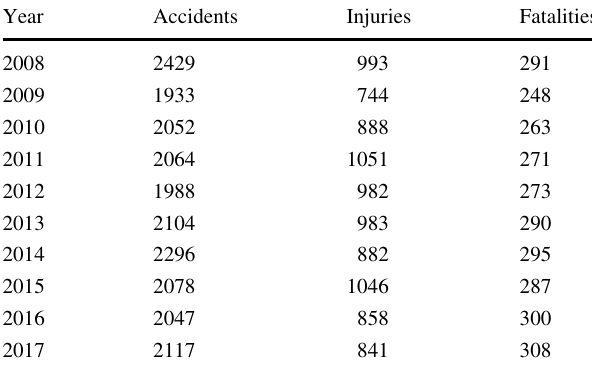
Table 1 Number of train–vehicle accidents, injuries, and fatalities in the USA between 2008 and